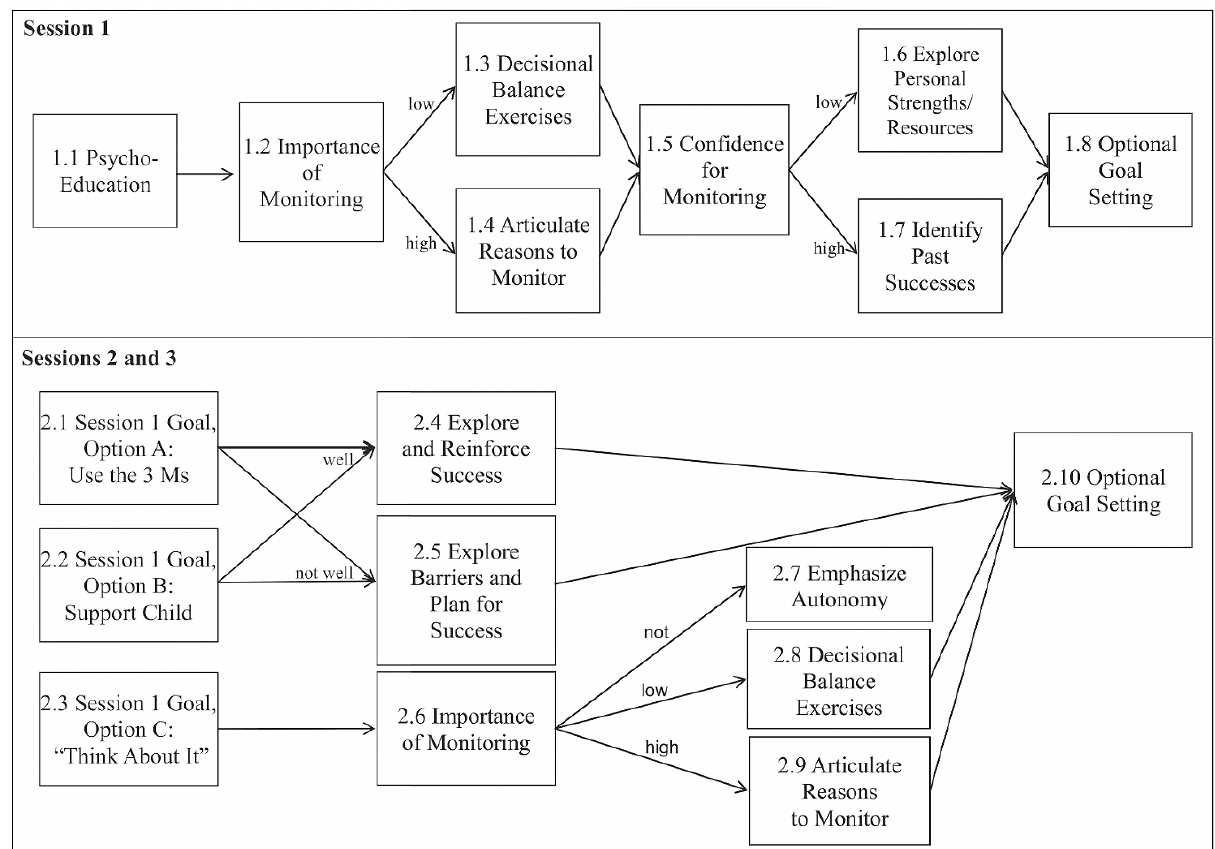
Figure 1. Flow chart of The 3 Ms